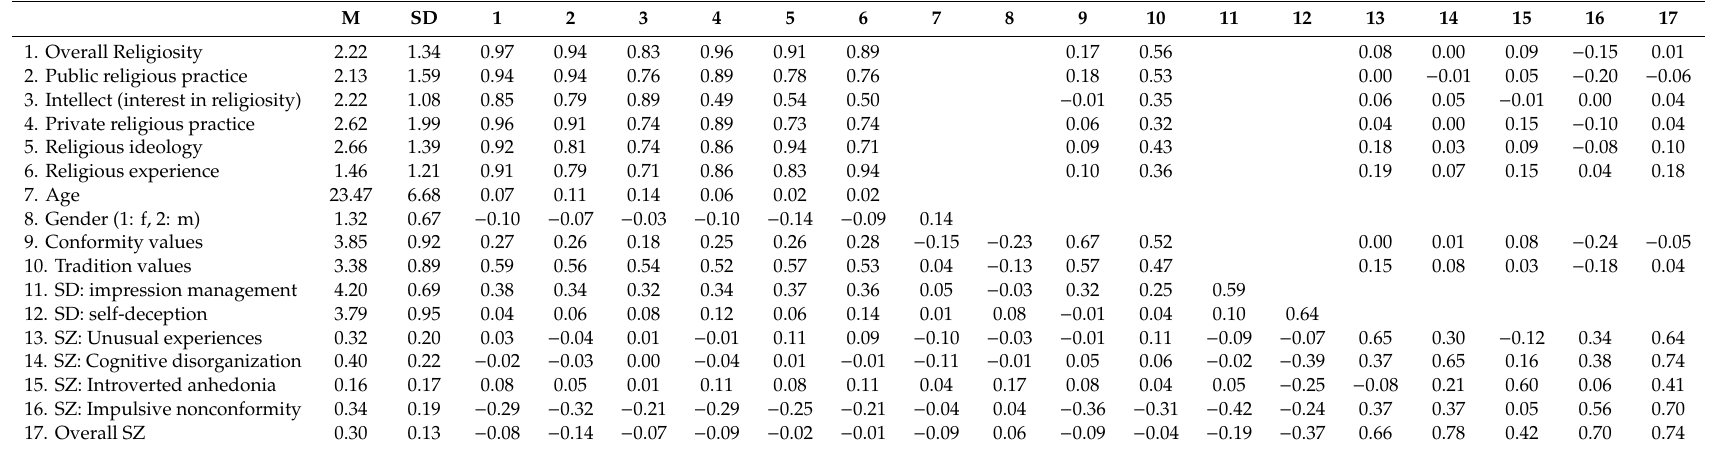
Table 1. Descriptive statistics, internal consistencies (main diagonal), zero-order correlations (below diagonal), and partial correlations (above